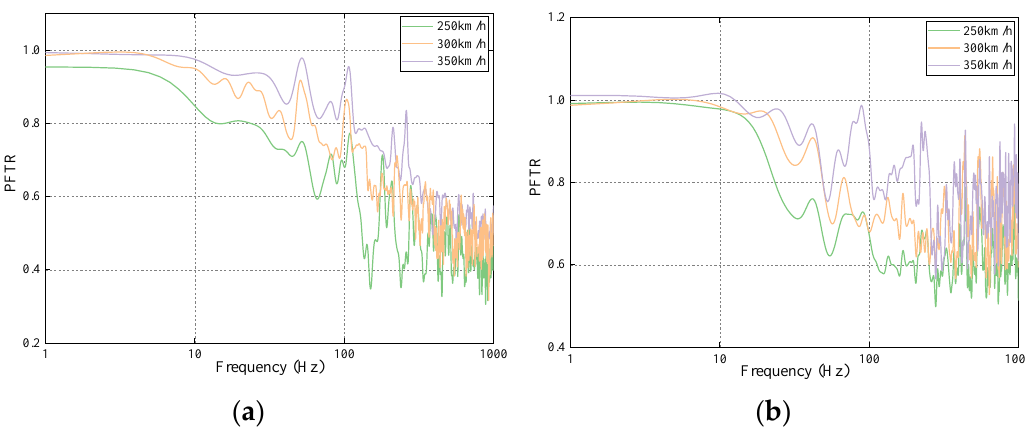
Figure 14. The PFTRs from ( a ) the rail to the slab track and ( b ) the slab track to the bridge.